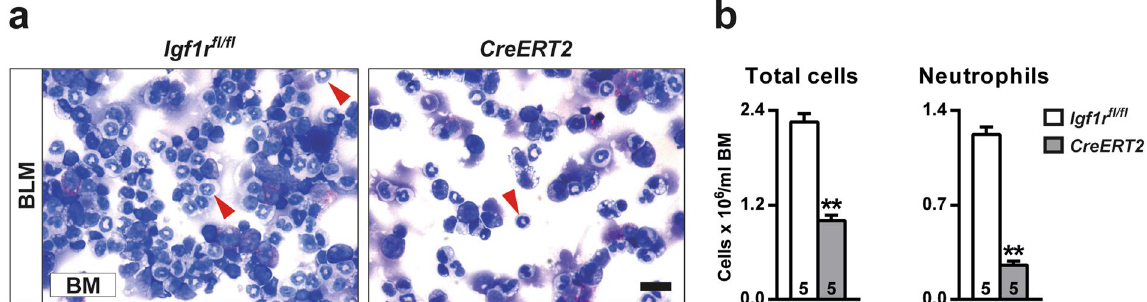
Figure 7. Reduced total and neutrophil counts in bone marrow from IGF1R-deficient mice. ( a , b ) Representative images, and total and neutrophil (red arrowheads) counts in bone marrow cytospin preparations from BLM-treated UBC-CreERT2 ; Igf1r fl / fl ( CreERT2 ) vs . Igf1r fl / fl mice at D3. Scale bar: 20 µ m. Numbers within graphic bars indicate the number of mice analyzed and data are expressed as mean ± SEM. ** p < 0.01 (Mann- Whitney U test). BLM, bleomycin; BM, bone marrow.